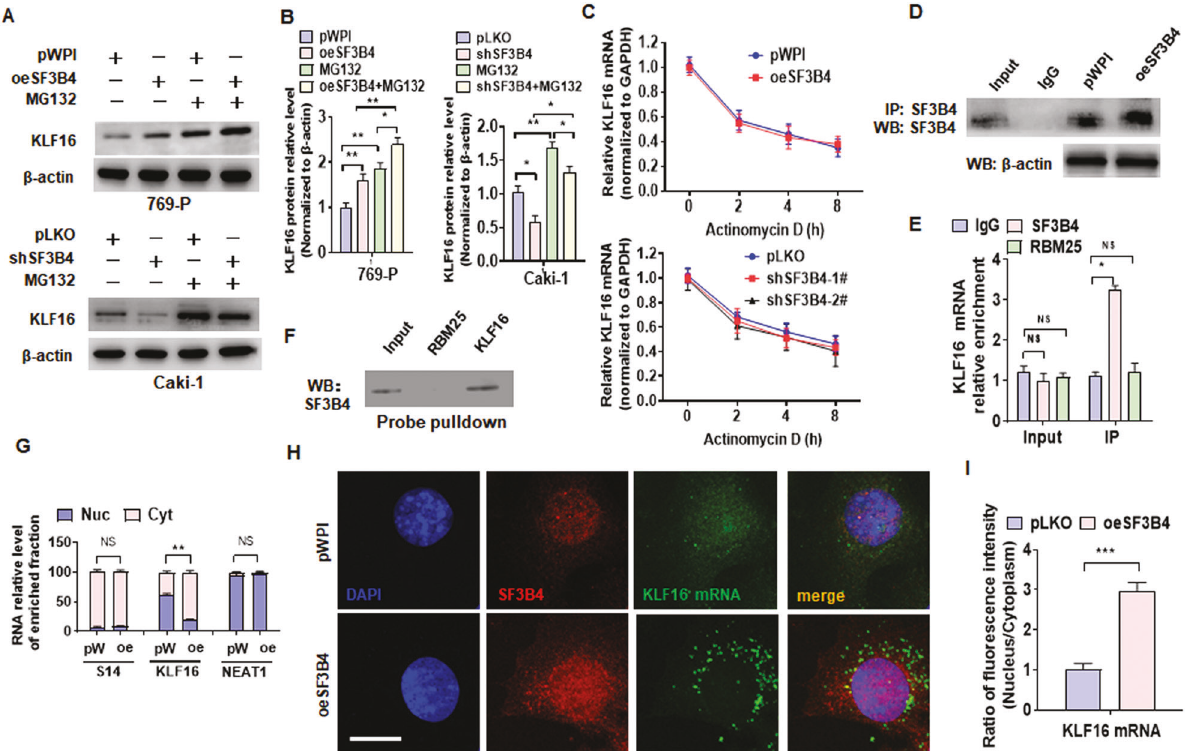
D-treated cells after transfection with the indicated constructs. D Caki-1 cells were transfected with oeSF3B4 or empty vector, and SF3B4 in the anti-SF3B4 immunoprecipitates was measured by Western blotting. E RNA binding protein immunoprecipitation assay (RIP) detected KLF16 mRNA enrichment by SF3B4 or RBM25 antibody. F Biotinylated RNA probes of KLF16 mRNA were used to pull down the RNA-protein complex, and the Western blot analysis detected SF3B4 enrichment. G Caki-1 cells were transfected with oeSF3B4 (oe) or pWPI (pW) and then RNA was isolated from the nucleus (Nuc) and cytoplasm (Cyt), mRNA of S14, KLF16, and NEAT RNA was detected by RT-qPCR. S14 acts as plasma- speci fi c RNA and NEAT1 RNA as nucleus-speci fi c RNA. H Caki-1 cells were treated as in G , and the expression of SF3B4 protein and KLF16 mRNA as well as their distribution in the nucleus and cytoplasm were detected by immuno fl uorescence combined with FISH. SF3B4 antibody (red) was used to detect SF3B4 protein, while the FITC-probe (green) was used to detect KLF16 mRNA. I Quantitative analysis of the KLF16 mRNA distribution in the nucleus and cytoplasm. Scale bar = 5 μ m. All data are expressed as the mean ± SEM of three independent experiments. * P < 0.05, ** P < 0.01, *** P < 0.001 vs. their corresponding RNA did not change signi fi cantly after overexpression of SF3B4